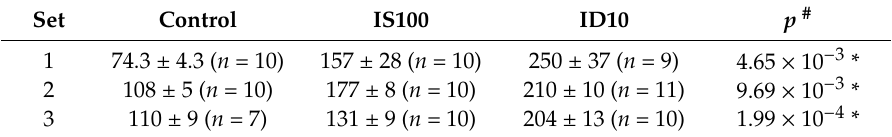
Table 4. Mean number of apoptotic events ( ± SEM) obtained in the control, IS100 and ID10 groups from 3 sets of experiments. n : numbers of embryos involved in the analyses. # p values obtained by comparing the IS100 and ID10 groups using one-tailed t -test (cases with p < 0.05 are asterisked).